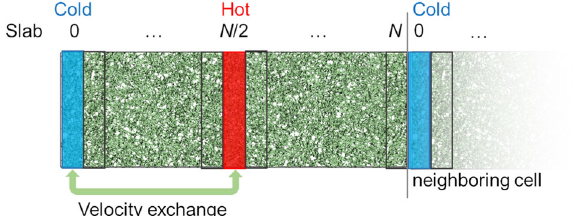
Fig. 9 Schematic representation of the simulation box for reverse nonequilibrium molecular dynamics. The red and blue slabs are the hottest and coldest region, respectively, in the simulation